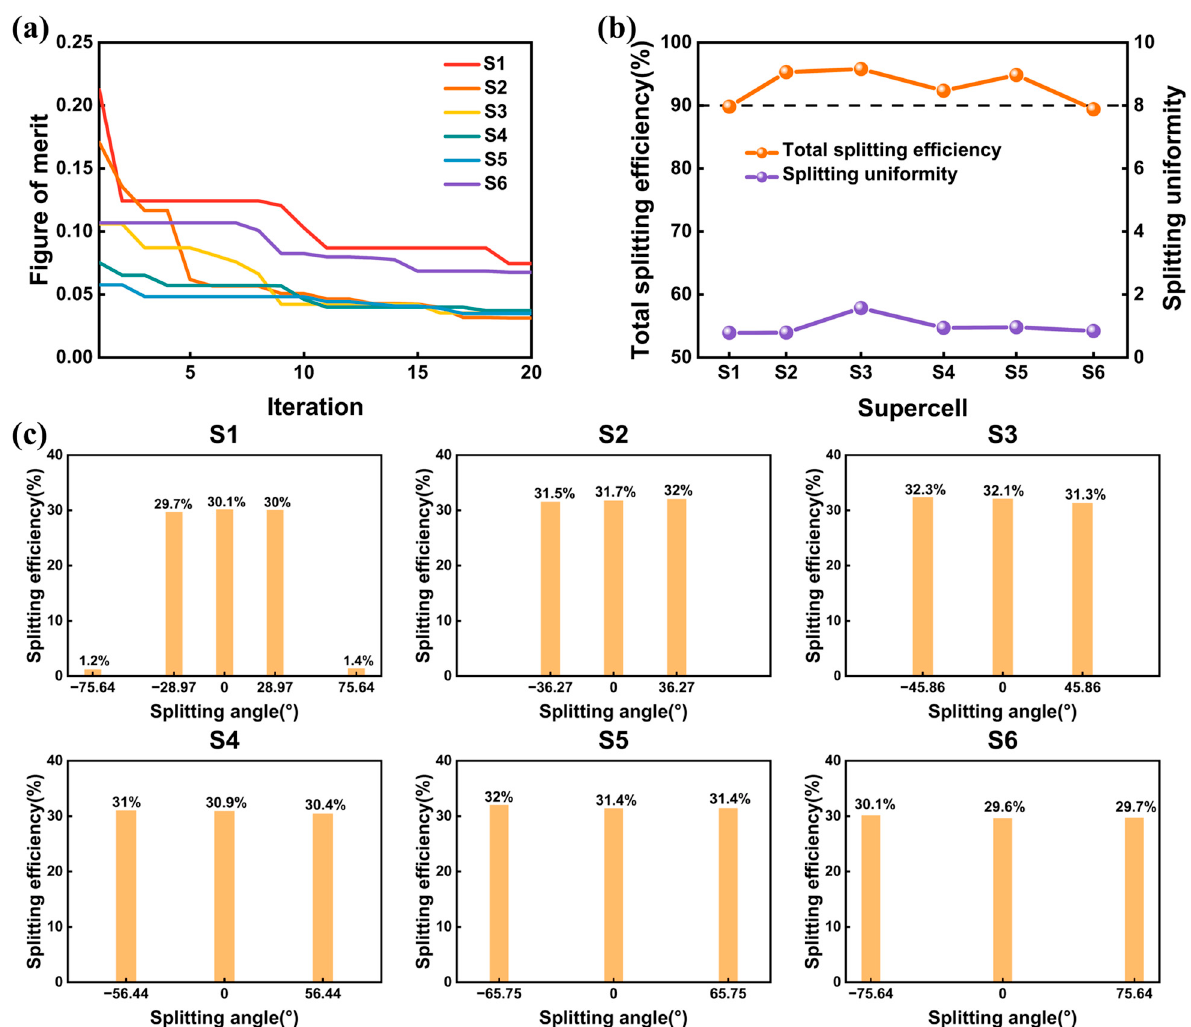
Figure 4 . ( a ) The optimization trajectories of metasurfaces for three port splitting output. ( b ) The total splitting efficiency and splitting uniformity 𝜎 of the six optimized structures. ( c ) Splitting efficiency at each channel of the optimized supercells.